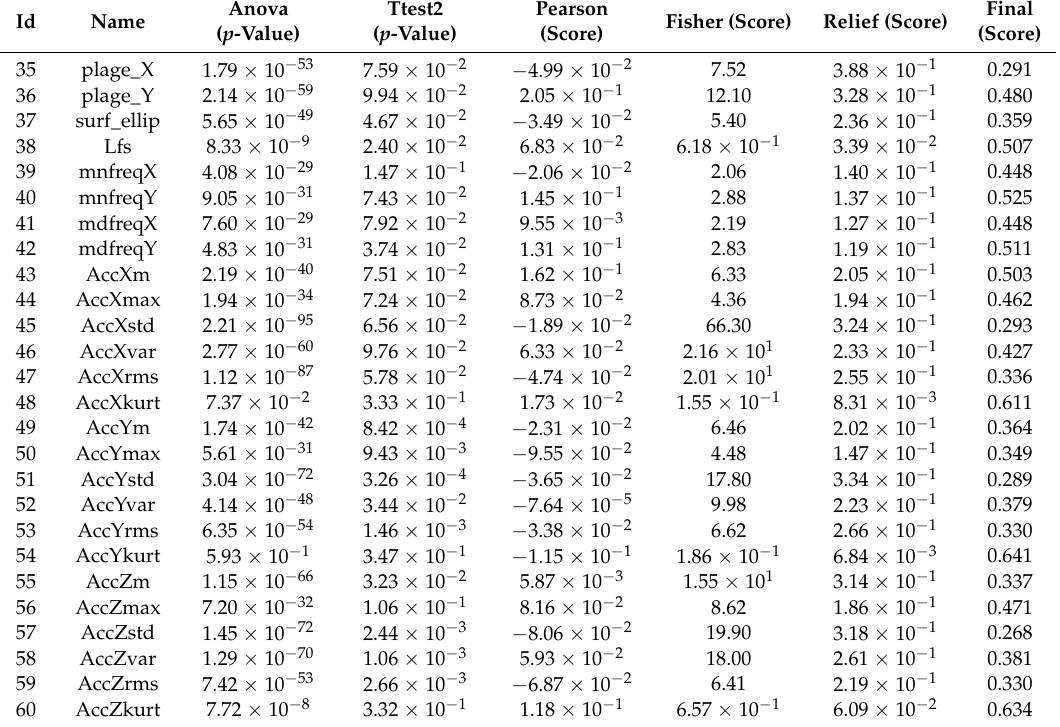
Table A2. Features kept by the filter feature selection methods.